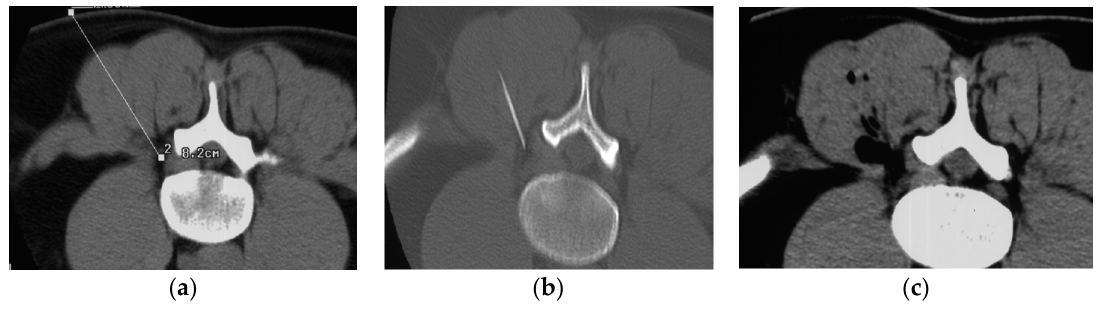
Figure 1. ( a ) Preliminary computed tomography (CT) measurements. The puncture site was identified by CT scan and marked on the patient’s skin. ( b ) Correct positioning of the needle. ( c ) Distribution of the gas mixture.